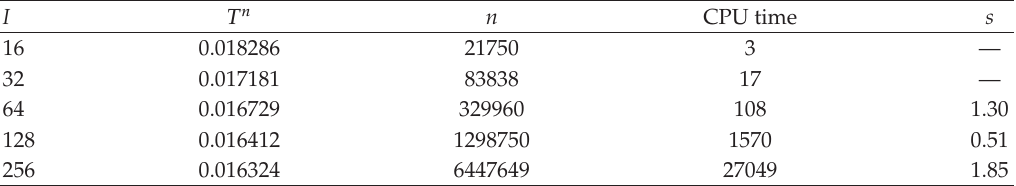
Table 3: Numerical blow-up times, numbers of iterations, CPU times (cid:3) seconds (cid:4) and orders of the approximations obtained with the explicit Euler method defined in (cid:3) 10.1 (cid:4) .